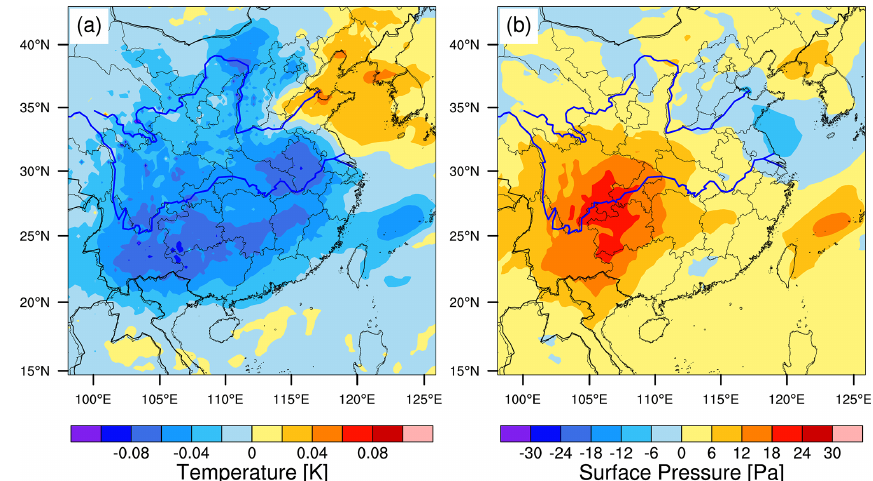
Figure 9. The spatial distributions of aerosol-induced difference (CTRL-CLEAN) of (a) atmosphere temperature below 500hPa and (b) sur- face pressure averaged for June and July 2017 from the small-domain simulations. Atmospheric temperature is weight-averaged by the layer thickness below 500hPa.